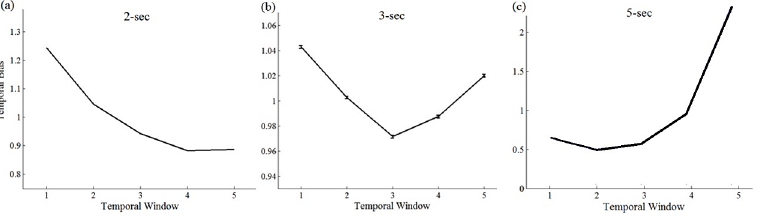
Fig 8. DLCA ’ s predicted temporal weights as a function of trial-duration (2-, 3- and 5-sec trials). The model ’ s predictions were generated using the best-fitting parameters that were obtained by fitting the DLCA to the decisions observed in the 3-sec trials.